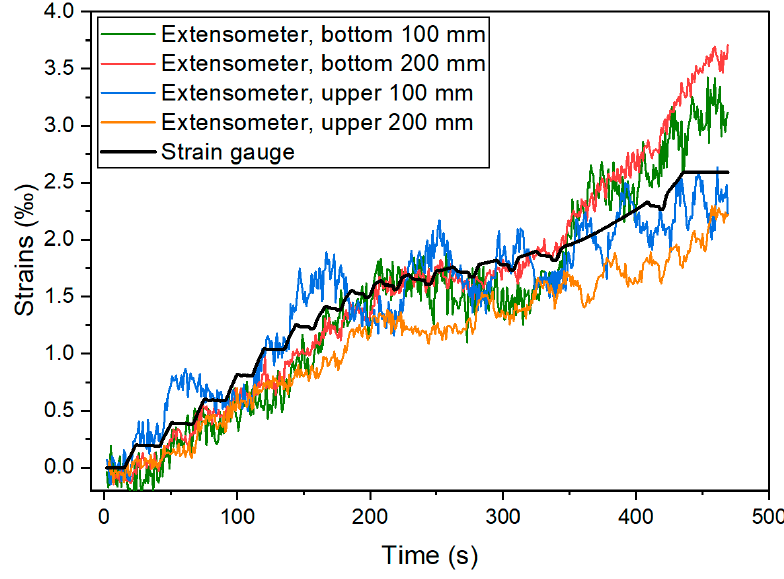
Figure 23. Comparison of the strain measurements in the plastic range in the α‐α section.